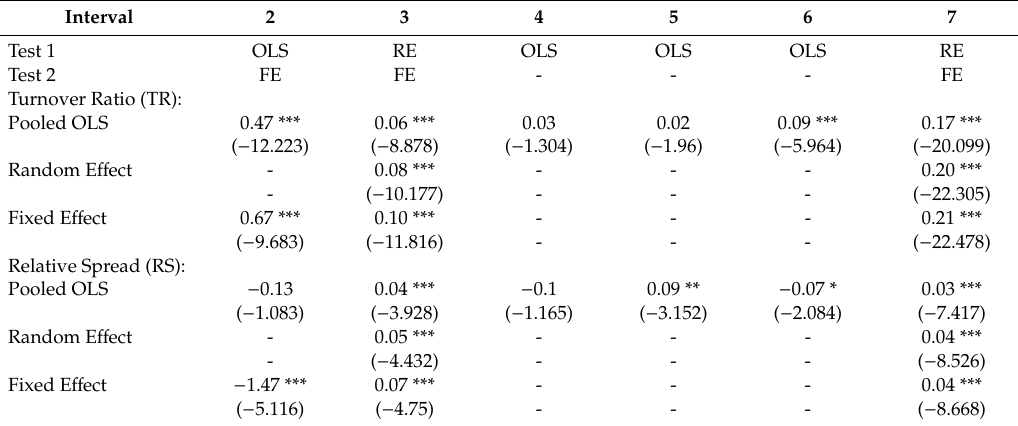
Table 5. Panel Data Analysis: Abnormal Returns—Liquidity measures (TR and RS).